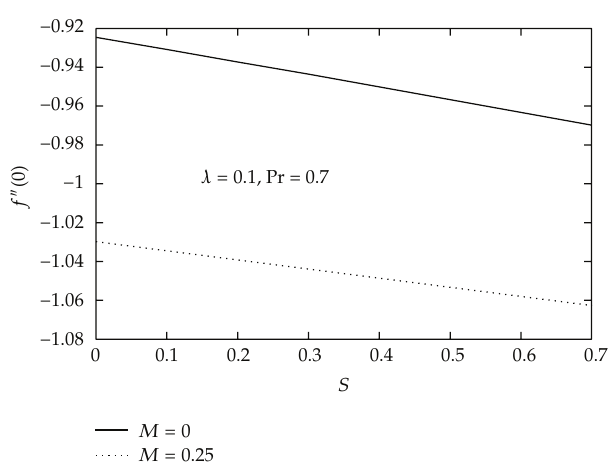
Figure 5: Skin friction coe ffi cient f (cid:4)(cid:4) (cid:6) 0 (cid:7) against the stratification parameter S for two values of the curvature parameter M when λ (cid:9) 0 . 1 and Pr (cid:9) 0.7.